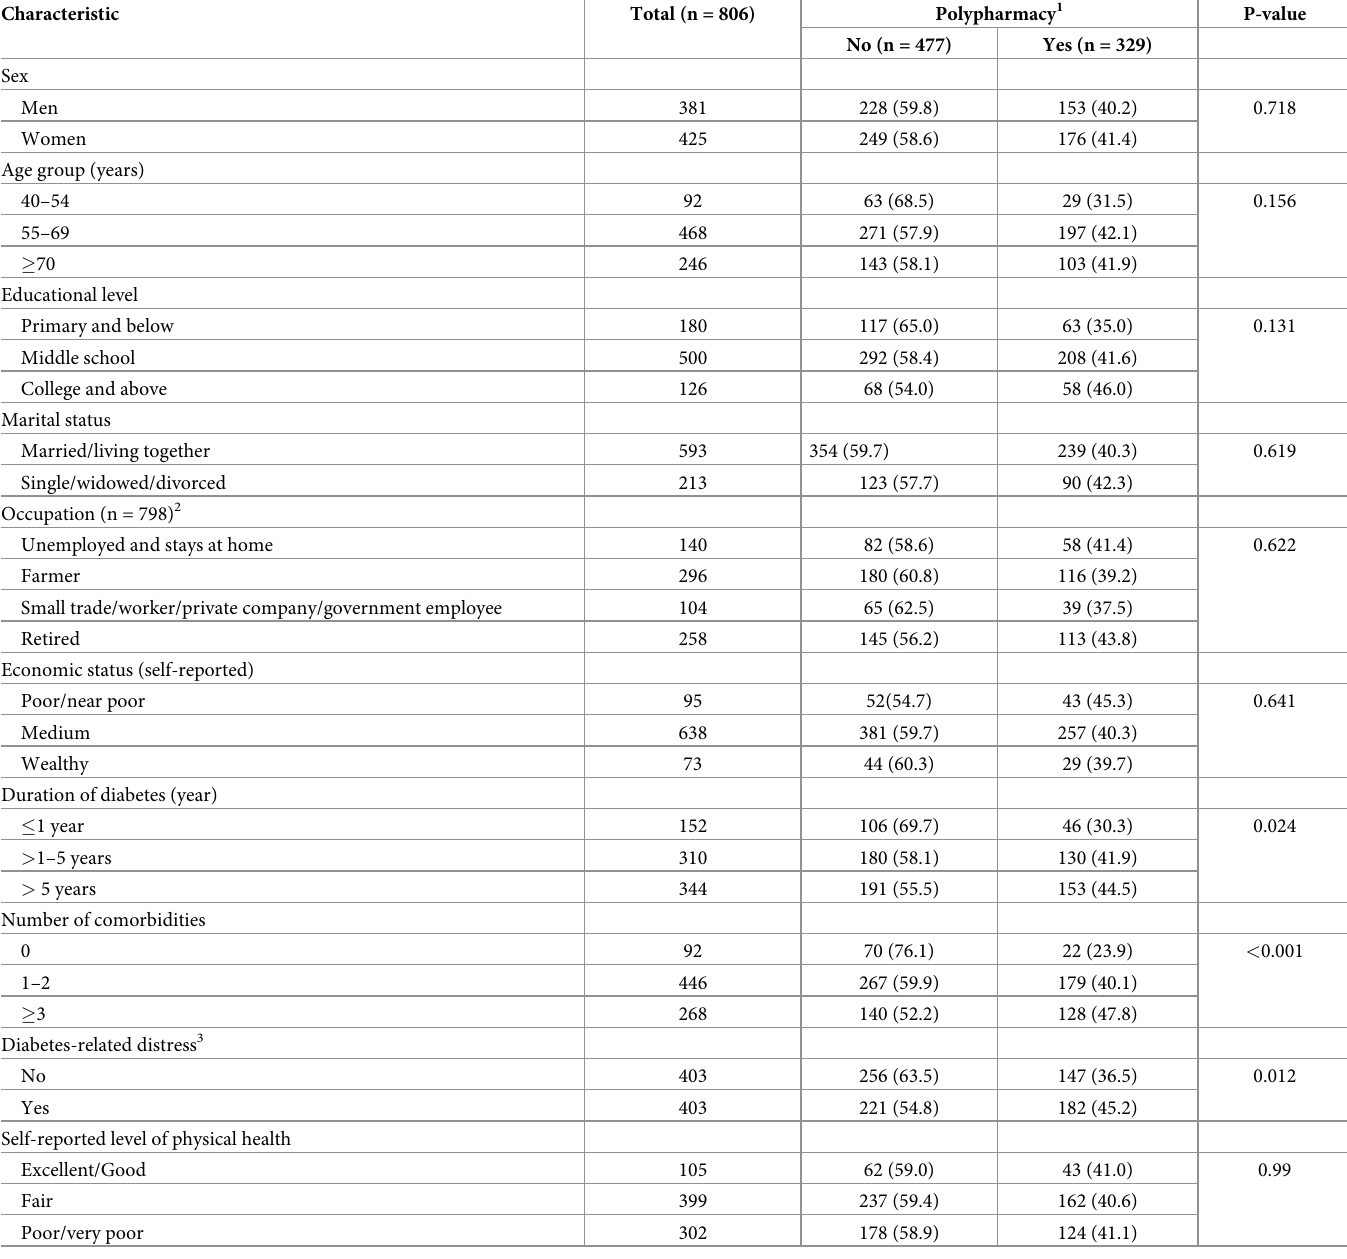
Table 2. Proportion of people living with T2D with polypharmacy according to demographic, economic and health characteristics.